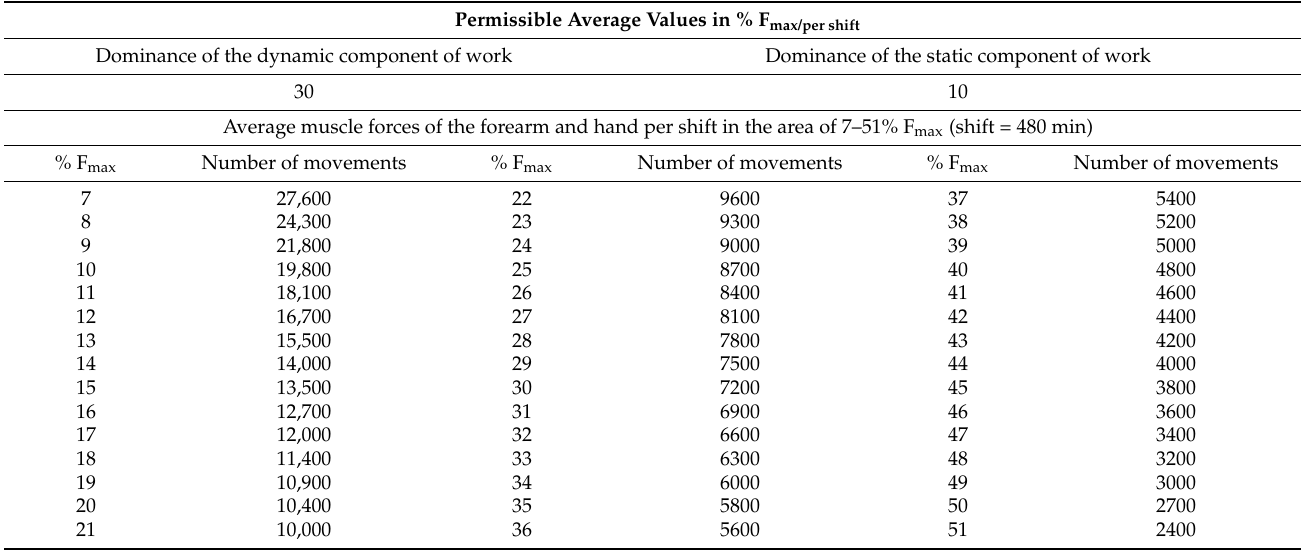
Table 4. Permissible values of the local muscle load